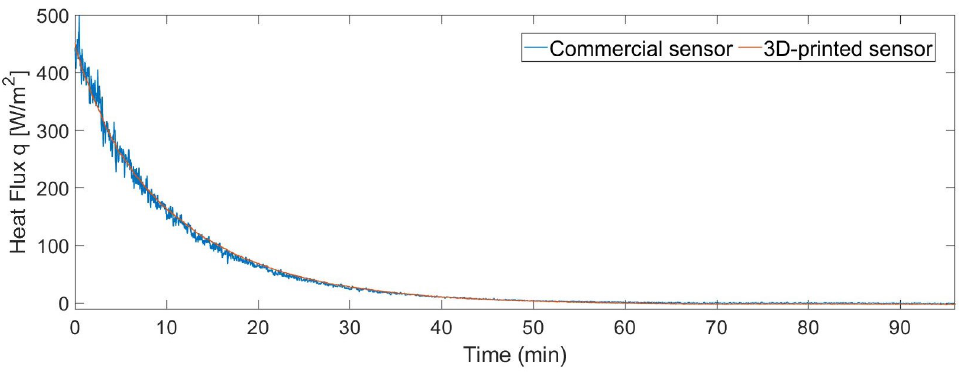
Figure 11. Comparison between the measurements of the commercial sensor and the 3D-printed sensor for a wide range of heat fluxes and a short period.